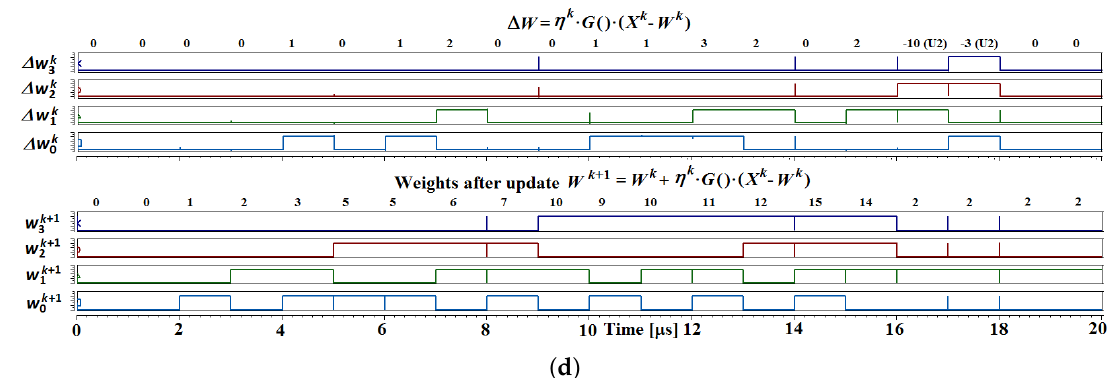
Figure 8. Simulations of the adaptation mechanism for different values of the P i , j ( k ) value: ( a ) an example sequence of the input signals x i ( k ) and corresponding neuron weights w i , j ( k ) ; ( b – d ) values of the updated neuron weights after the adaptation process w i , j ( k + 1 ) for: ( b ) P i , j ( k ) = 4/16;